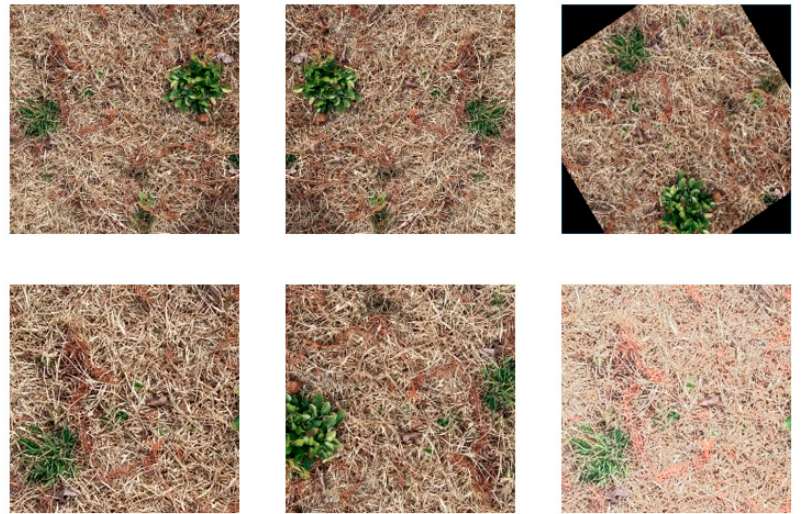
Figure 7. Example images of geometric data augmentation methods (from left to right): original image; horizontal flip; random rotation; random crop; flip + random crop; random crop + photomet- ric distortion.